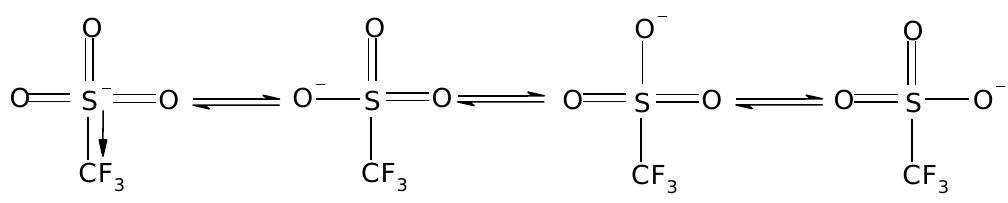
Figure 3. Resonance state of triflate anions.